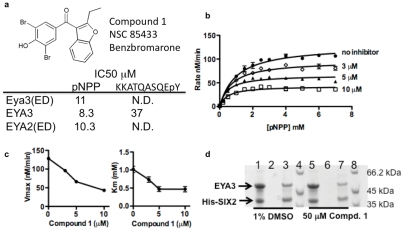
EYA inhibitor Benzbromarone, compound 1.(a) Compound 1 was identified from a screen of the NCI Diversity Set II library. IC50 values for compound 1 were measured for Eya3(ED), human EYA3 and human EYA2(ED) using as substrates the phosphotyrosine mimic pNPP and a phosphopeptide representing the last 10 amino acids of H2AX, a known EYA substrate. (b) Substrate titration shows that compound 1 is an uncompetitive inhibitor of EYA3(ED). Increasing concentration of substrate does not overcome inhibition. Each point represents the mean and standard deviation of two independent readings. (c) Plots of Vmax and Km as a function of inhibitor concentration show that both values decrease with increased inhibitor concentration. Values in (c) were derived from nonlinear regression analyses of curves in (b) using PRISM (GraphPad Software). (d) Compound 1 does not affect the interaction between EYA3 and SIX2. Recombinant purified EYA3 and His-SIX2 were mixed and treated with either the vehicle control (1% DMSO) (lane 1) or 50 μM compound 1 (lane 5) for 15 minutes at room temperature. The mixture was loaded on a Ni-NTA column. Beads were washed with 3 column volumes of load buffer (last washes, lanes 2 and 6). Proteins retained on the beads are shown in lanes 3 and 7. Lanes 4 and 8 are molecular weight markers.